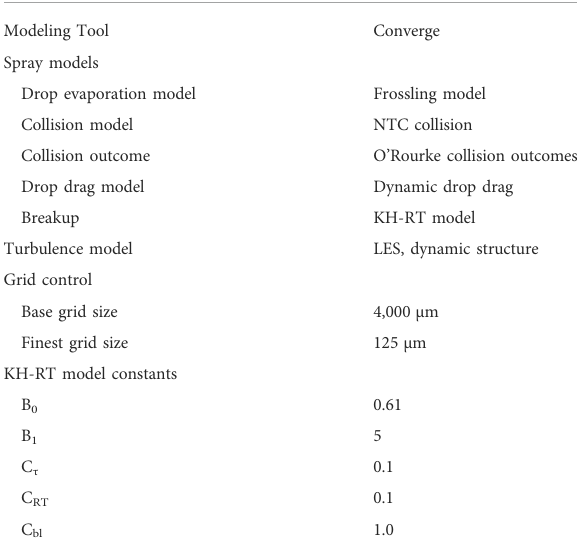
FIGURE 1 Geometry characteristics of the combustion chamber and computational domain of the studied LES.